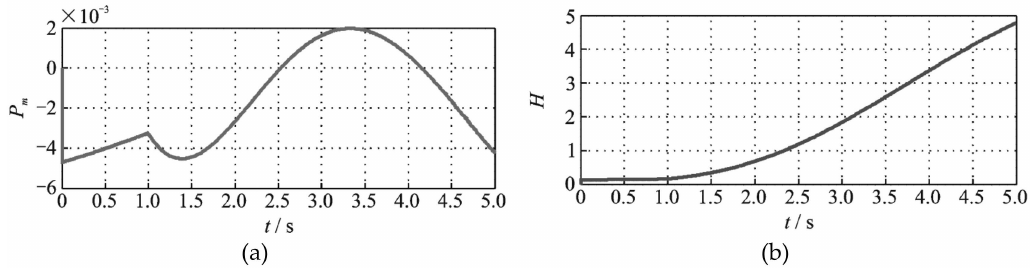
Figure 29. Variations in unit power output and Hamiltonian functions under the step disturbance of load. ( a ) Variation in unit power output, ( b ) variation in Hamiltonian functions [47].